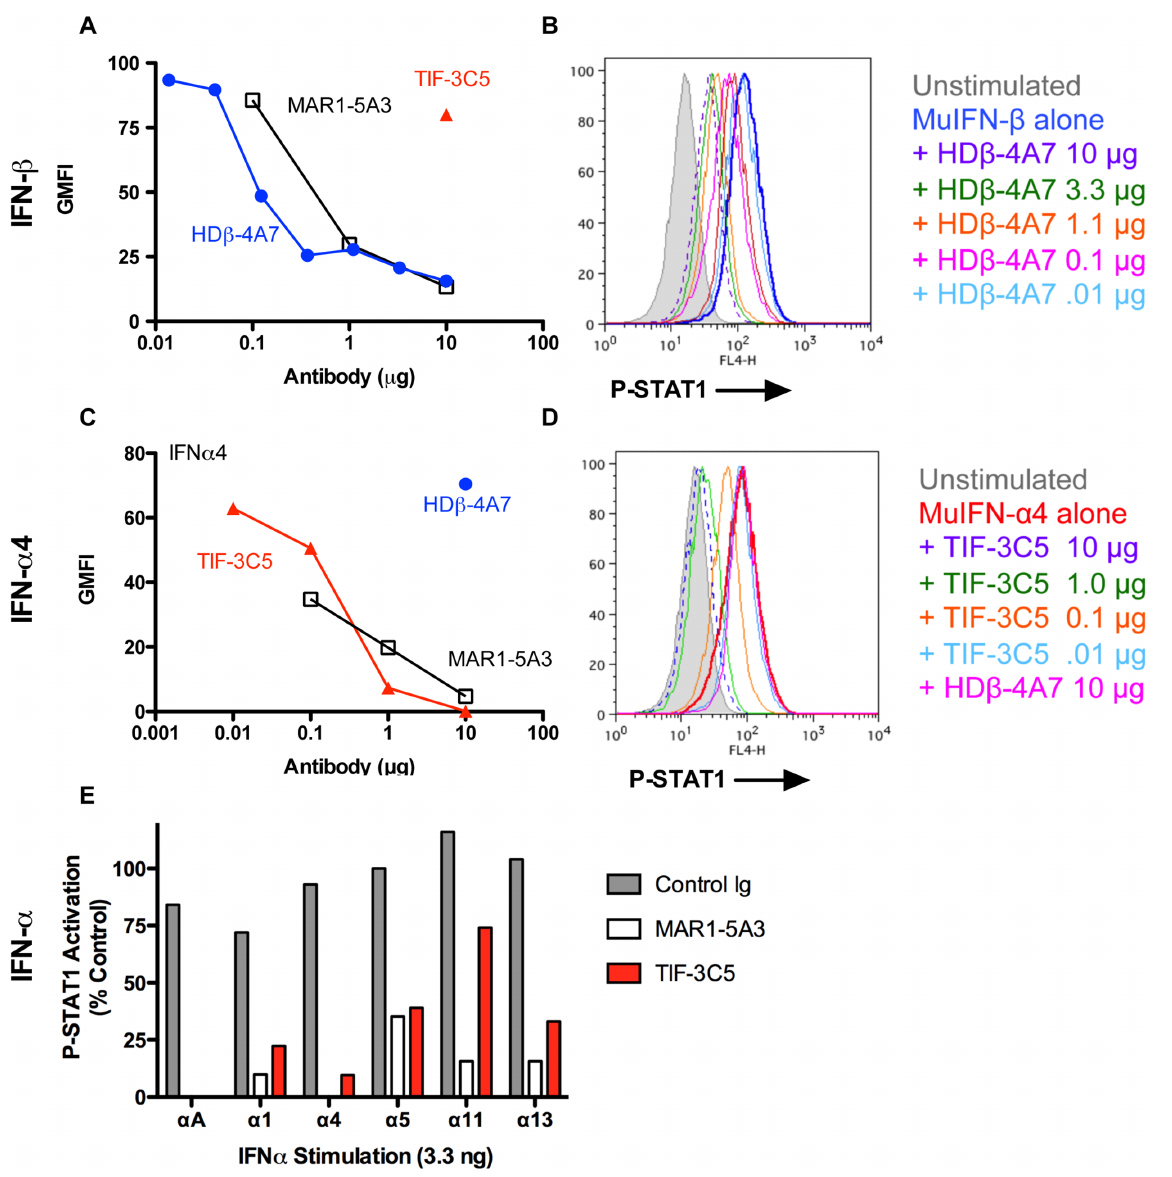
Fig 1. Blockade of type I IFN activation of P-STAT1 in vitro . Titrations of HD β -4A7 and TIF-3C5 (0.01 – 10 μ g) or MAR1-5A3 (10 μ g) were preincubated for 60 min with 3 ng of IFN- β ( A, B ) or 3.3 ng of IFN- α 4 ( C, D ) and then incubated with L929 cells for 20 min, followed by staining for P-STAT1 and processing by flow cytometry. E . Individual IFN- α subtypes (3.3 ng) were preincubated with 10 μ g of mAb and then incubated with L929 cells for 20 min, followed by staining for P-STAT1 and flow cytometric analysis. Data are representative of three or more independent experiments.